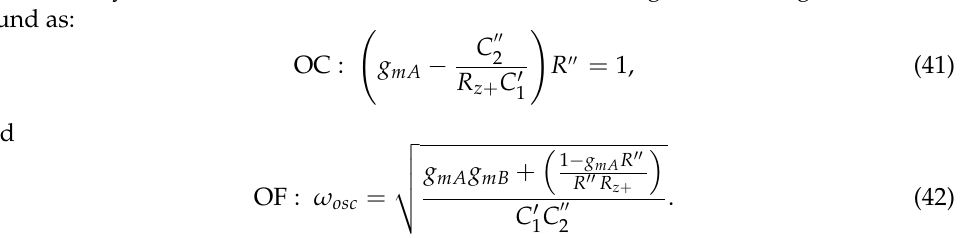
Table 2. Aspect ratios of the CMOS transistors of the VDGA in Figure 2.